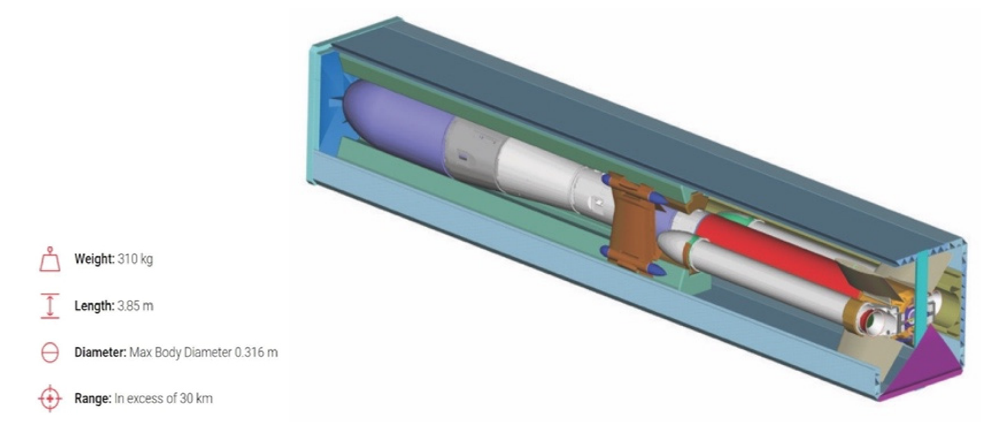
Figure 3. Marte ER System and Missile CAD.